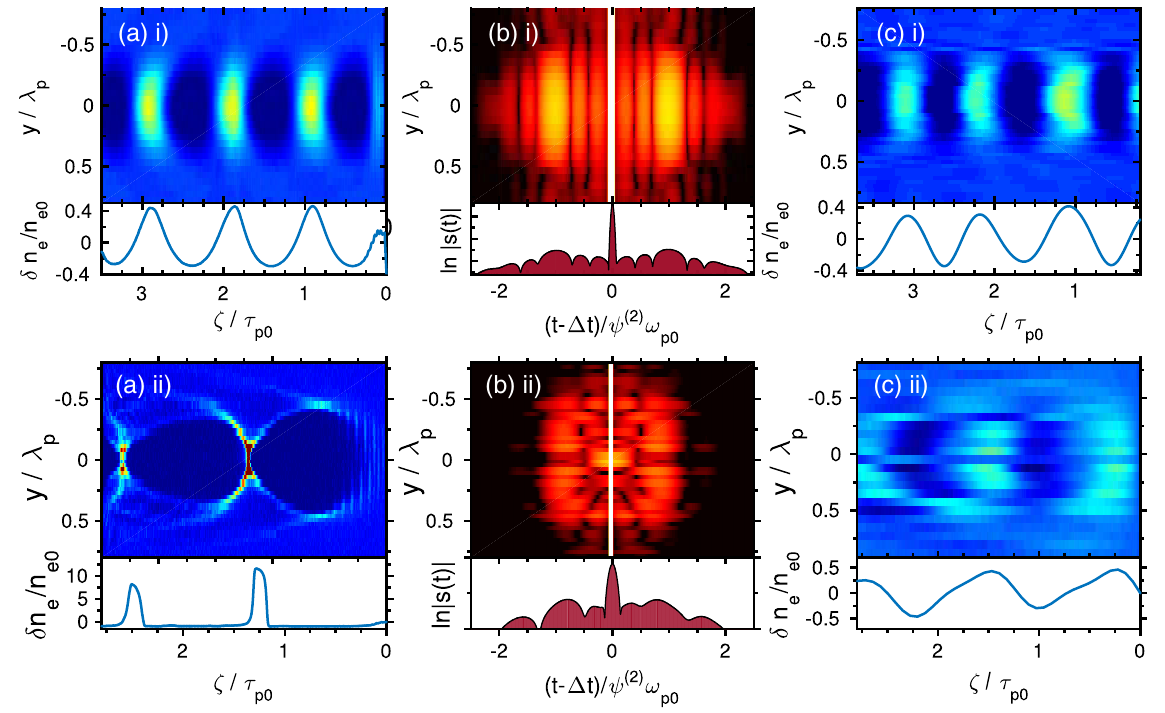
FIG. 5. (a) Simulated electron density maps of a wakefield in (i) a weakly nonlinear regime and (ii) the strongly non-linear bubble regime. (b) Maps of the calculated TESS signal resulting from these density profiles, plotted in both space and in time against the expected peak positions. The magnitude of the TESS signal is plotted on a logarithmic scale. (c) A reconstruction of the electron density map of the wakefield using the TESS analysis, using N ¼ 4 peaks from the TESS signal. In all plots the profile on-axis is shown